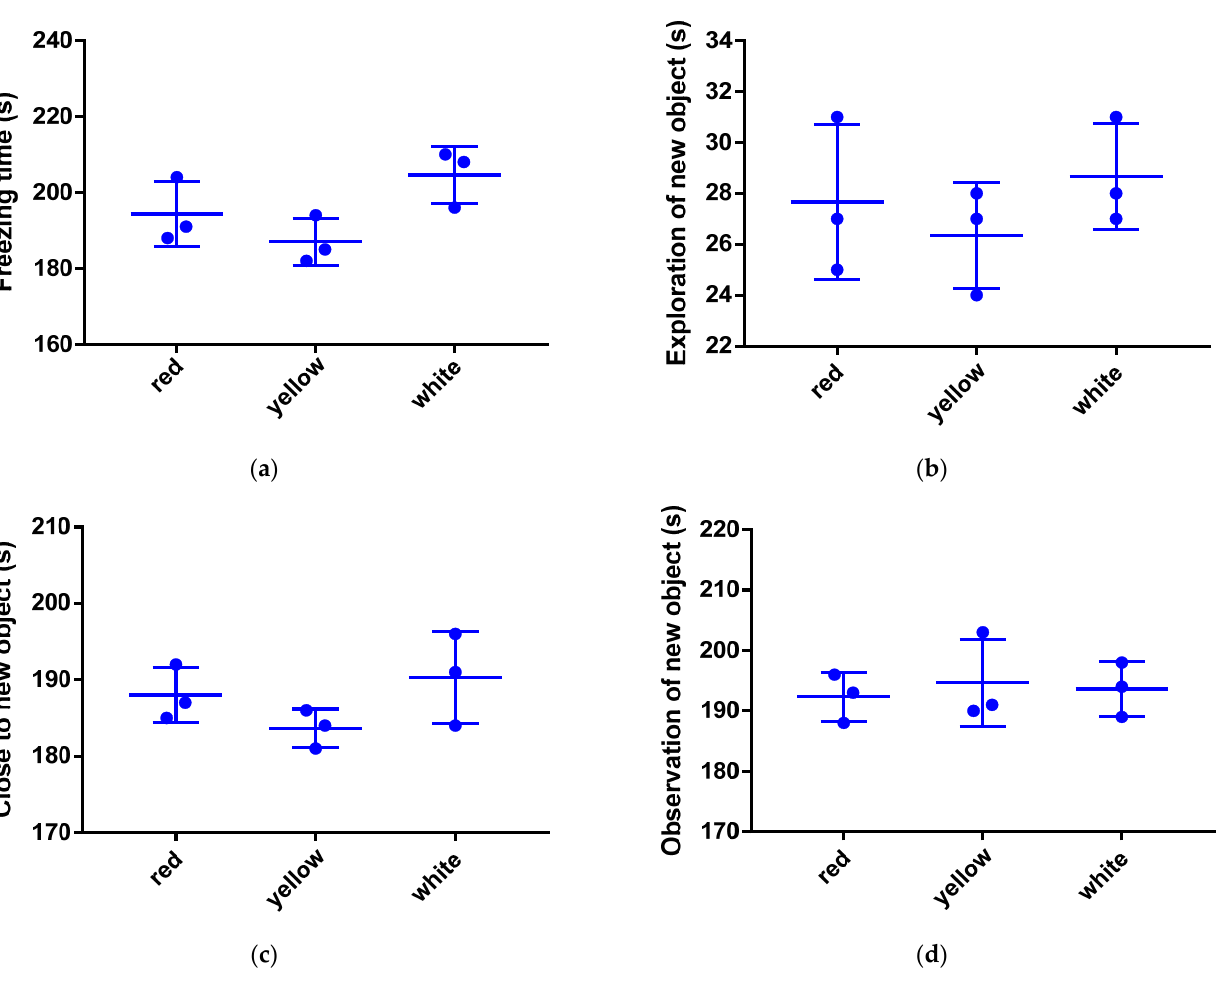
Figure 3. The effect of three-color bionic robot fish on the fear and exploratory behavior of crucian carp. ( a ) Freezing time; ( b ) Exploration time of new object; ( c ) Time close to new object; ( d ) Observation time of new object. Values are represented as mean ± SD of data from triplicates per treatment ( n = 3).